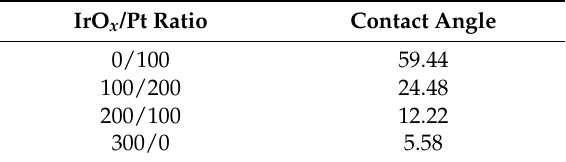
Figure 2. Top-view SEM images of annealed IrO x -Pt composite films on Ti substrate; ( a ) sputtered Pt, Table 1. A summary of relations between IrO x /Pt ratio and contact angle.